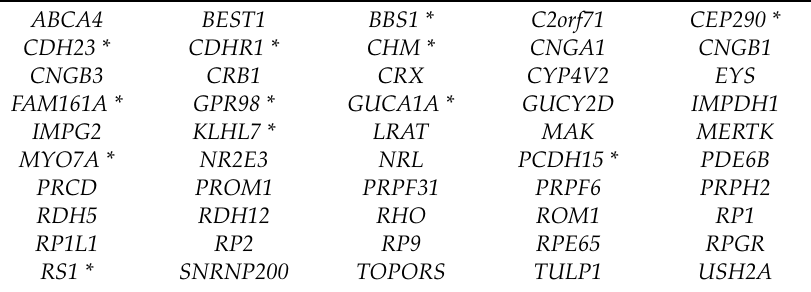
Table 6. The list of genes in our target capture